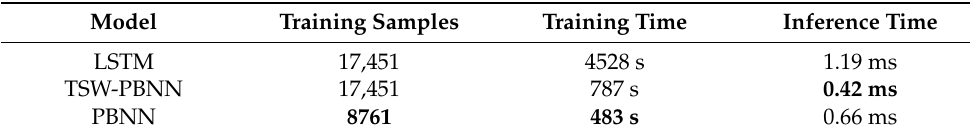
Table 5. Computation time of LSTM, TSW-PBNN, and PBNN.